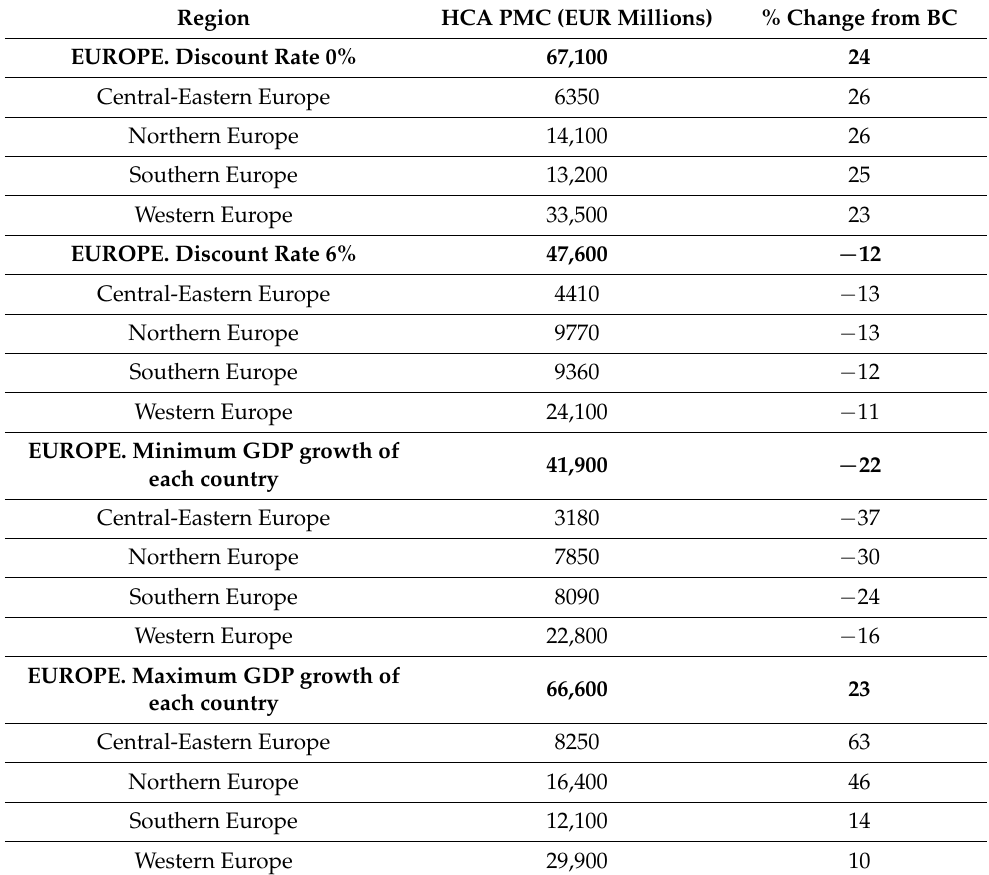
Table 4. Sensitivity analysis of cancer-related premature mortality costs (PMC) (EUR, total) using the Human Capital Approach with comparison to the base case *. Region HCA PMC (EUR Millions) % Change from BC EUROPE. Discount Rate 0%